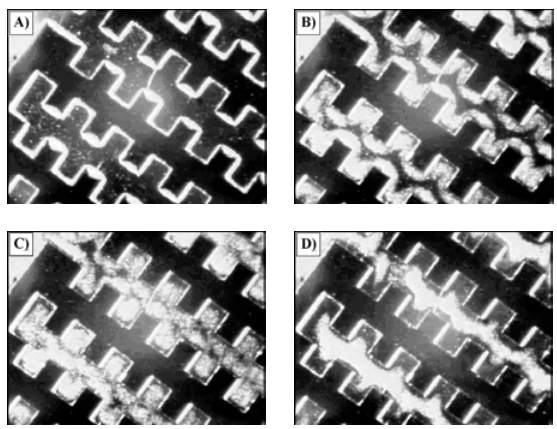
Fig. 7 – Sequence of bacterial movement over the interdigitated castel- lated microstructure. The applied voltage was 10 V. Frames were cap- tured at: (a) 100 kHz, (b) 20 kHz, (c) 10 kHz, and (d) 1 kHz. E. coli were diluted in de-ionized water ( σ m = 10 μ S cm − 1 ) , Magnification ×